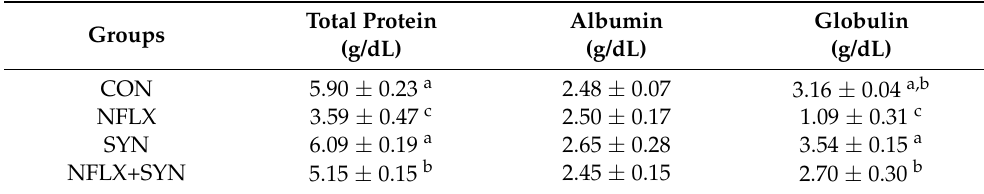
Table 2. Comparison of the proteinogram of Nile tilapia, O. niloticus , fed with diets containing antibiotic (norfloxacin, NFLX) and synbiotic (SYN).